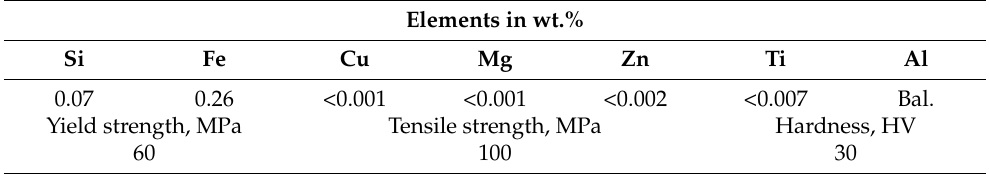
Table 2. Nominal chemical composition and mechanical properties of aluminum alloy AA1050-H14.